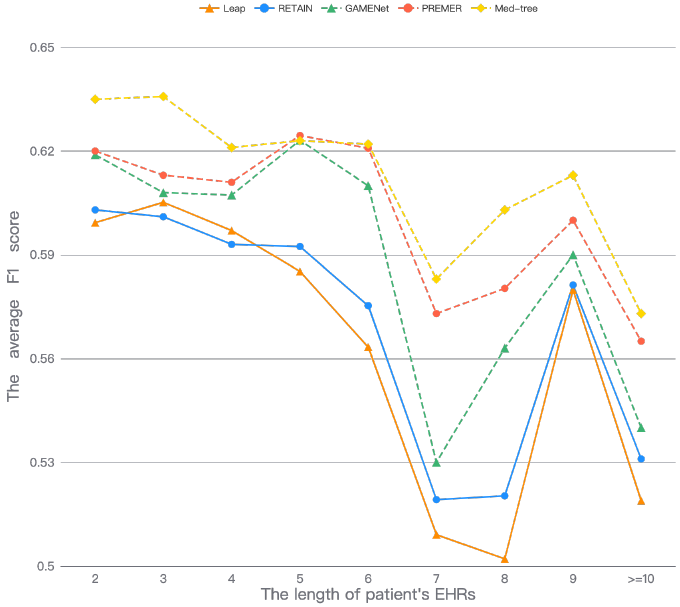
Figure 7. The comparisons of average F1 score recommended by different methods (Leap [43], RETAIN [21], GAMENet [22], PREMIER [44], and Med-tree) for EHRs with different temporal lengths on MIMIC-III